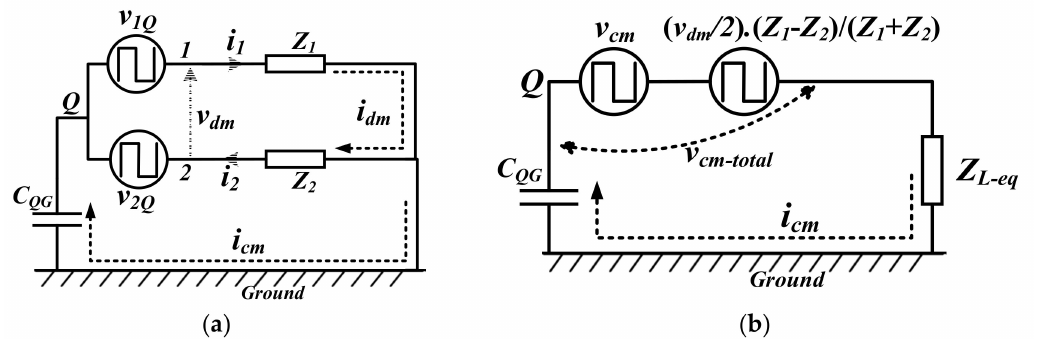
Figure 2. ( a ) Common-mode equivalent circuit of single-phase grid-connected converter, ( b ) simplified equivalent circuit for the total common-mode